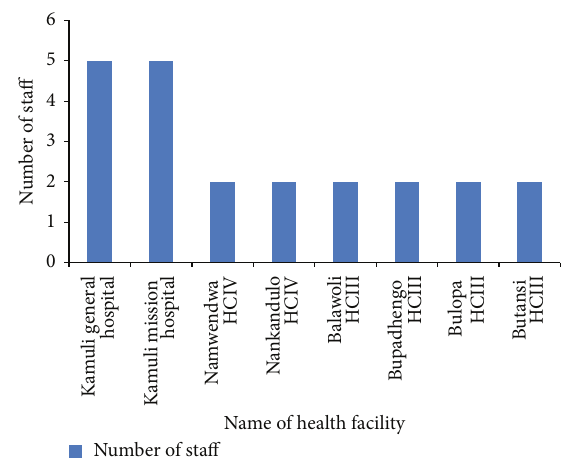
Figure 2: Laboratory staffing levels of health facilities in Kamuli district, March–May